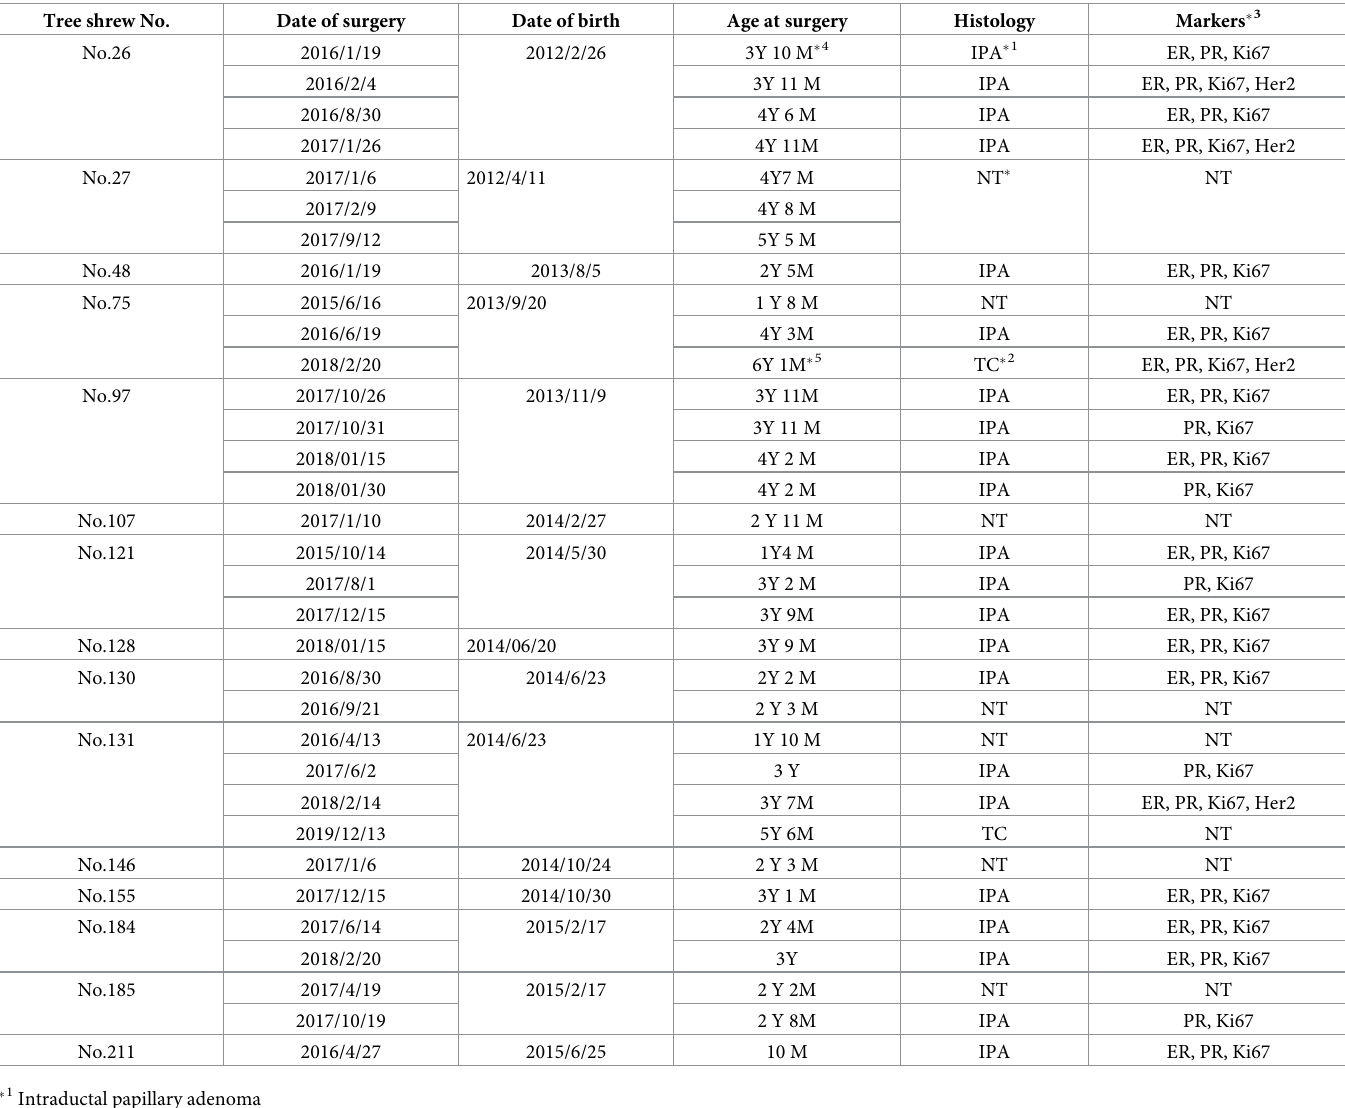
Table 1. Summary of tree shrews with mammary tumors. Tree shrew